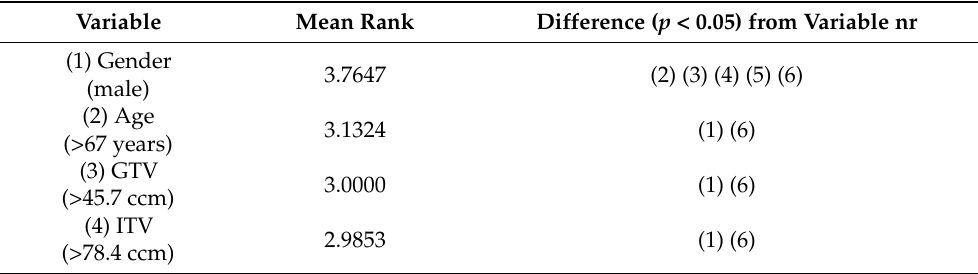
Table 3. Friedman test: F = 14.99; df 1 = 5; df 2 = 165; p < 0.00001. Multiple